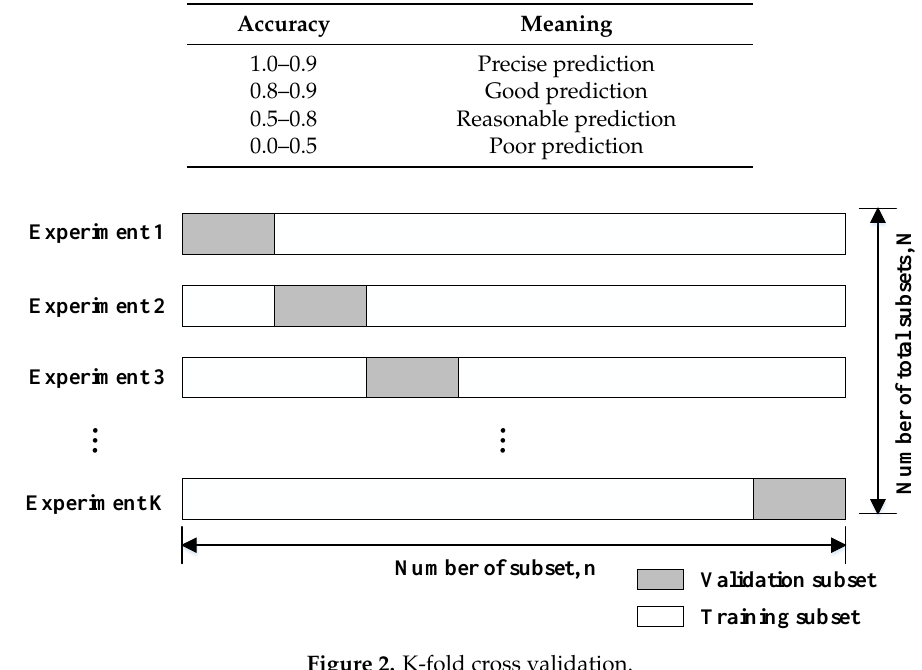
Figure 2. K-fold cross validation.